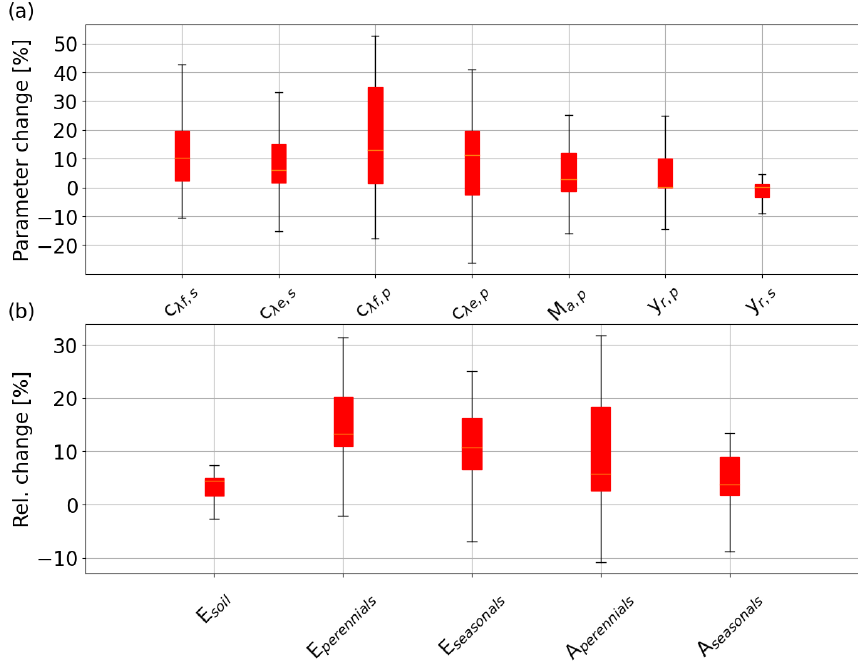
Figure 6. Simulated changes in response to a 20% increase in precipitation in the VOM (based on Fig. 4) for (a) optimized vegetation properties, with the water-use parameters for perennial ( c λf, p and c λe, p ) and seasonal vegetation ( c λf, s and c λe, s ), perennial vegetation cover ( M A, p ), and root depths for the perennial and seasonal vegetation ( y r , p and y r , s ); and (b) fluxes with soil evaporation ( E soil ), transpiration of perennial trees ( E perennials ), transpiration of seasonal grasses ( E seasonals ), gross primary productivity (GPP) of perennial trees ( A perennials ), and GPP of seasonal grasses ( A seasonals